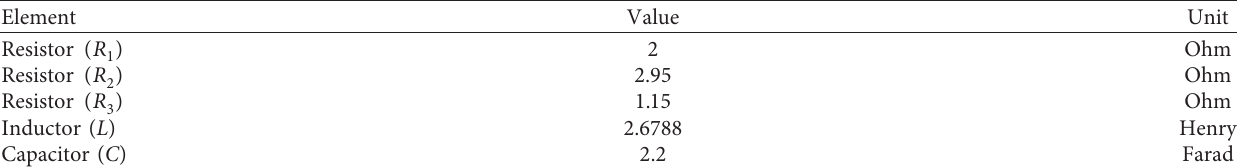
Table 1: Circuit parameter.